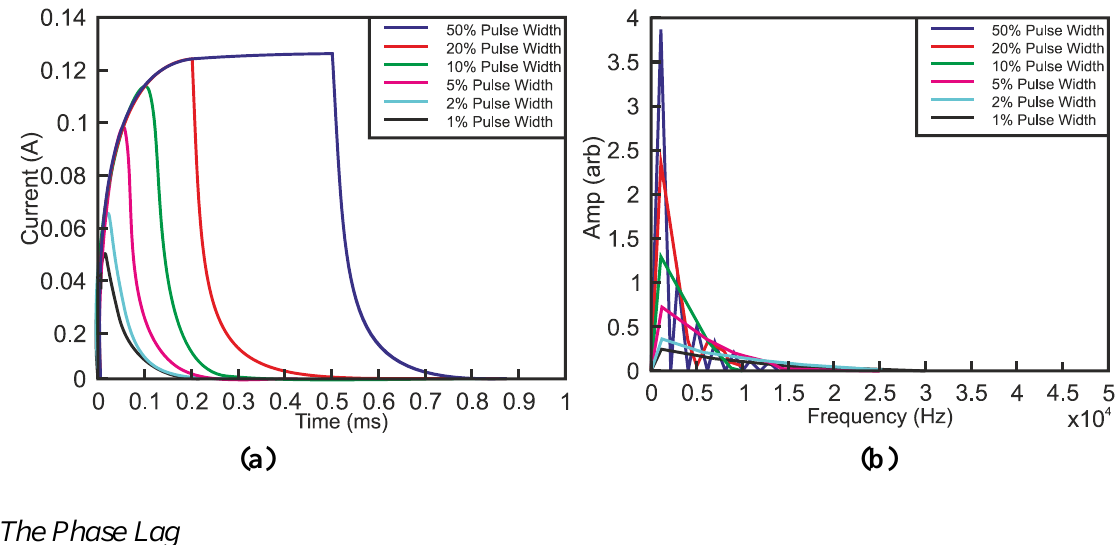
Figure 16. (a) Excitation current input with varied pulse width (adapted from [53]). (b) Spectrum distribution under different pulse widths (adapted from